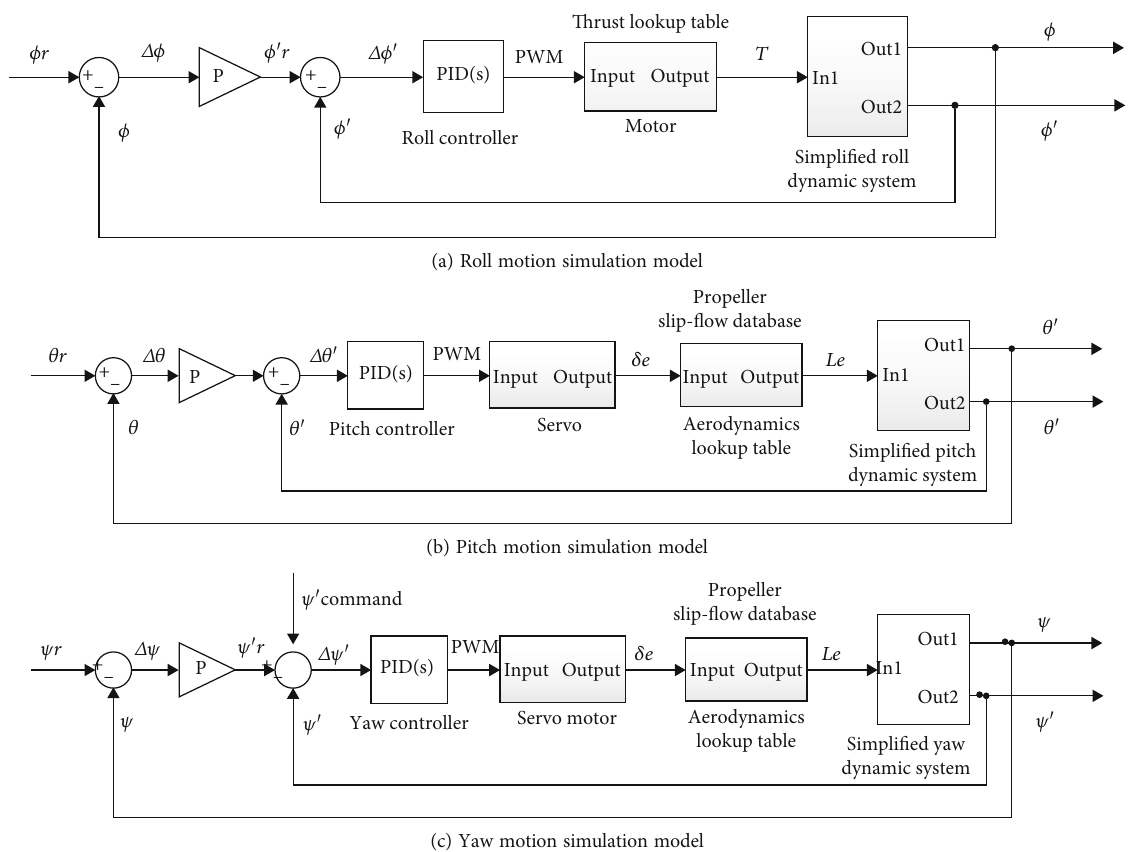
Figure 5: The decoupled roll, pitch, and yaw motion simulation model.